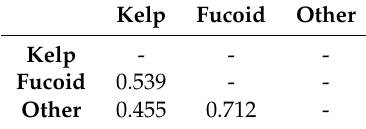
Table 2. ANOSIM group pairwise R values. All p -values < 0.001. All permutation values = 999. Kelp Fucoid Other Kelp - - - Fucoid 0.539 - - Other 0.455 0.712 -